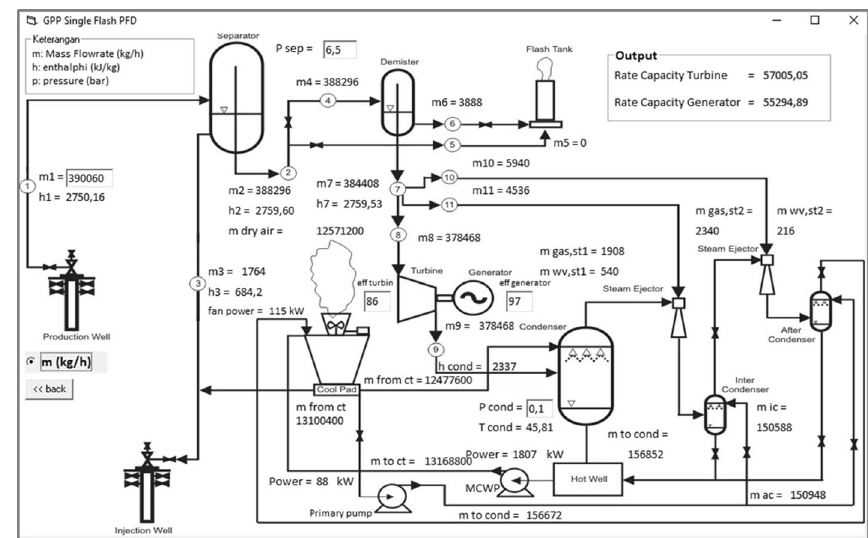
Fig. 15 Screen results of Kamojang Units 2 and 3 types of ejector systems